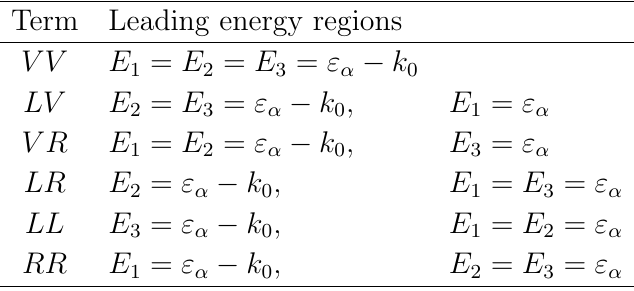
Table 1: Energy regions emphasized by the ∆ the contributions to S (4) . See text after Eq.